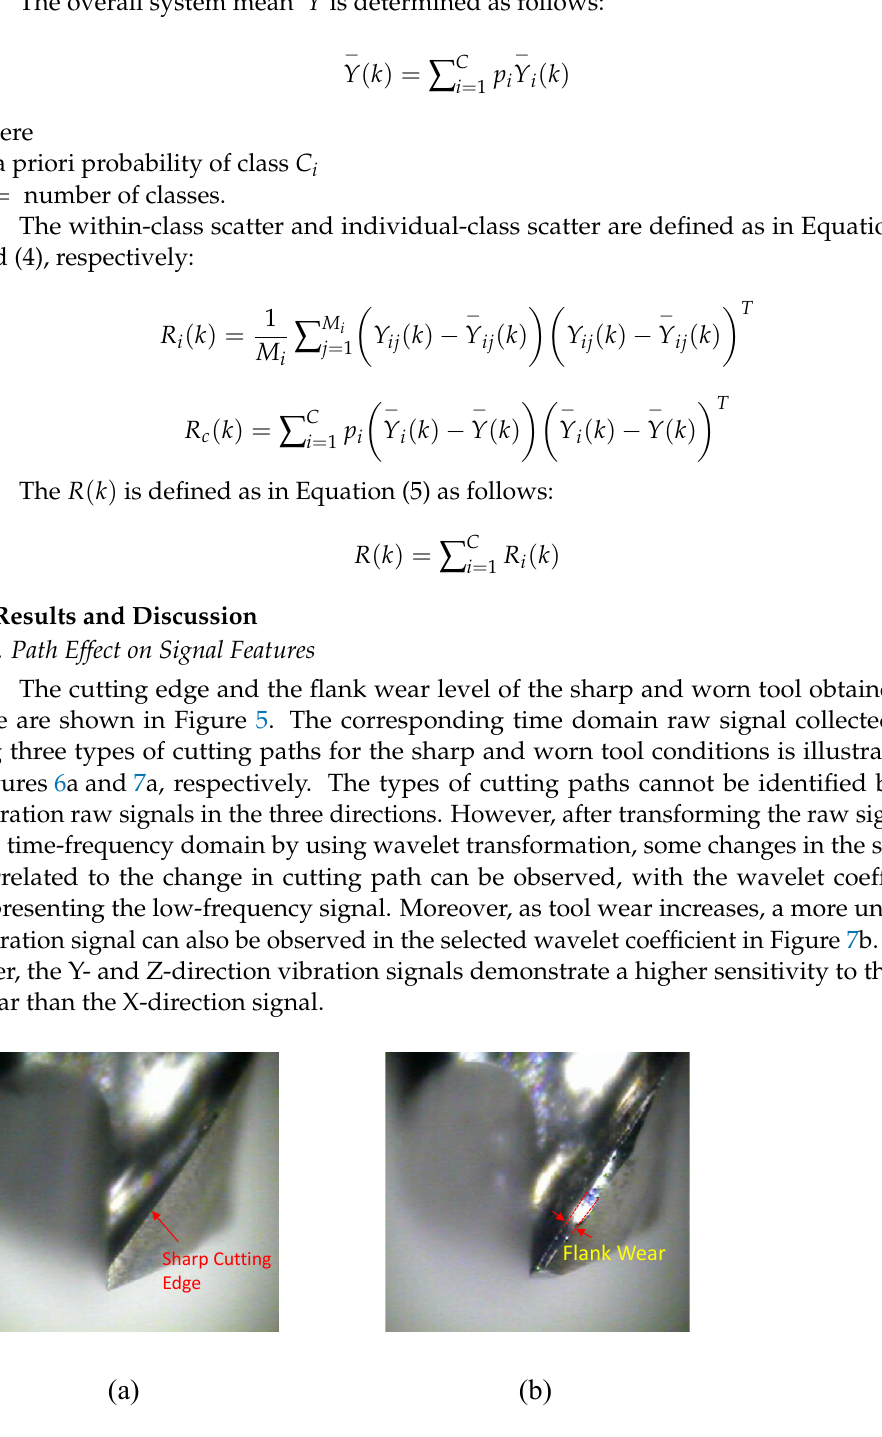
Figure 5. Tool wear condition for signal collection: ( a ) sharp tool; ( b ) 30 μm tool wear level.